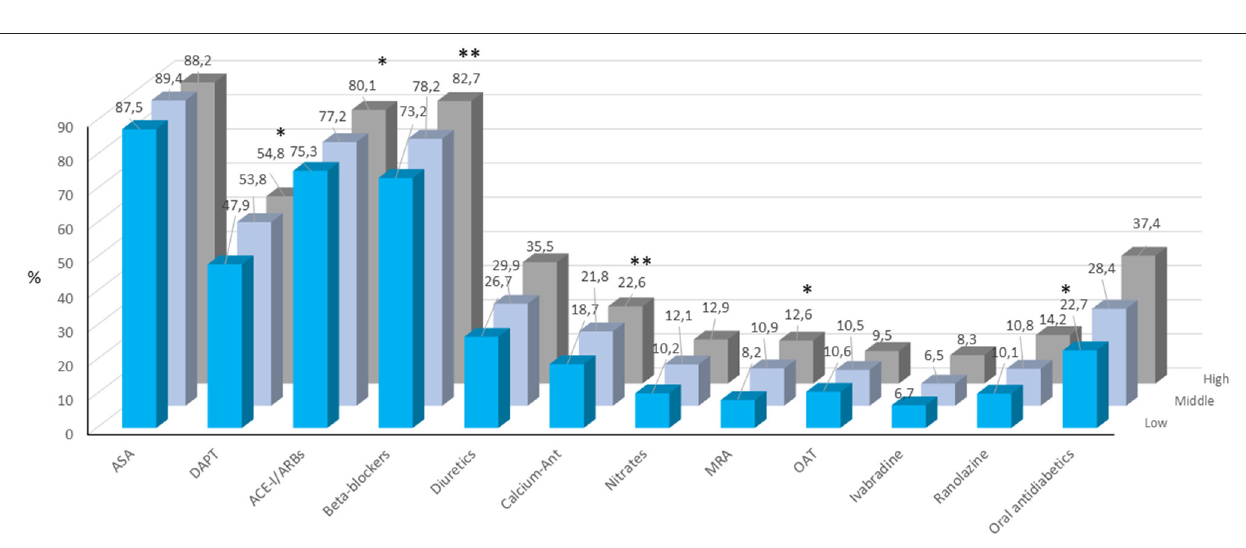
FIGURE 2 | Pharmacological treatment at enrolment in patients included the three TG/HDL-C tertiles. ACE-I, angiotensin converting enzyme inhibitors; ARB, angiotensin receptor blockers; ASA, acetylsalicylic acid; CCA, calcium channels antagonists; MRA, mineralocorticoid receptor antagonist; OAT, oral anticoagulant therapy. * p < 0.05; ** p <